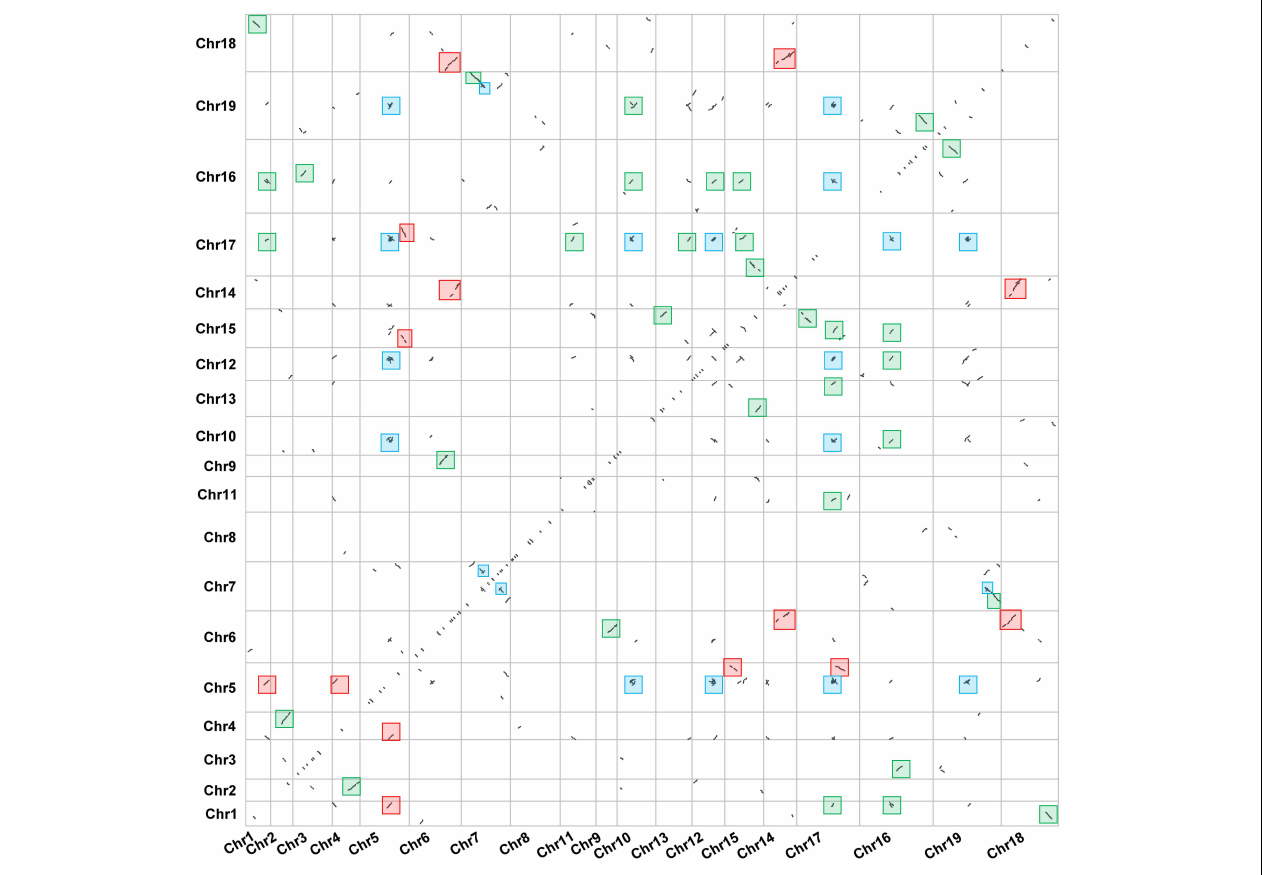
FIGURE 1 | The genome dotplot of D. huoshanense. The dot lines denote the duplication events that occur between two chromosomes. The blue boxes represented the ancient WGD events. The red boxes represented the large-scale WGT events. The green boxes represented the recent WGD events.